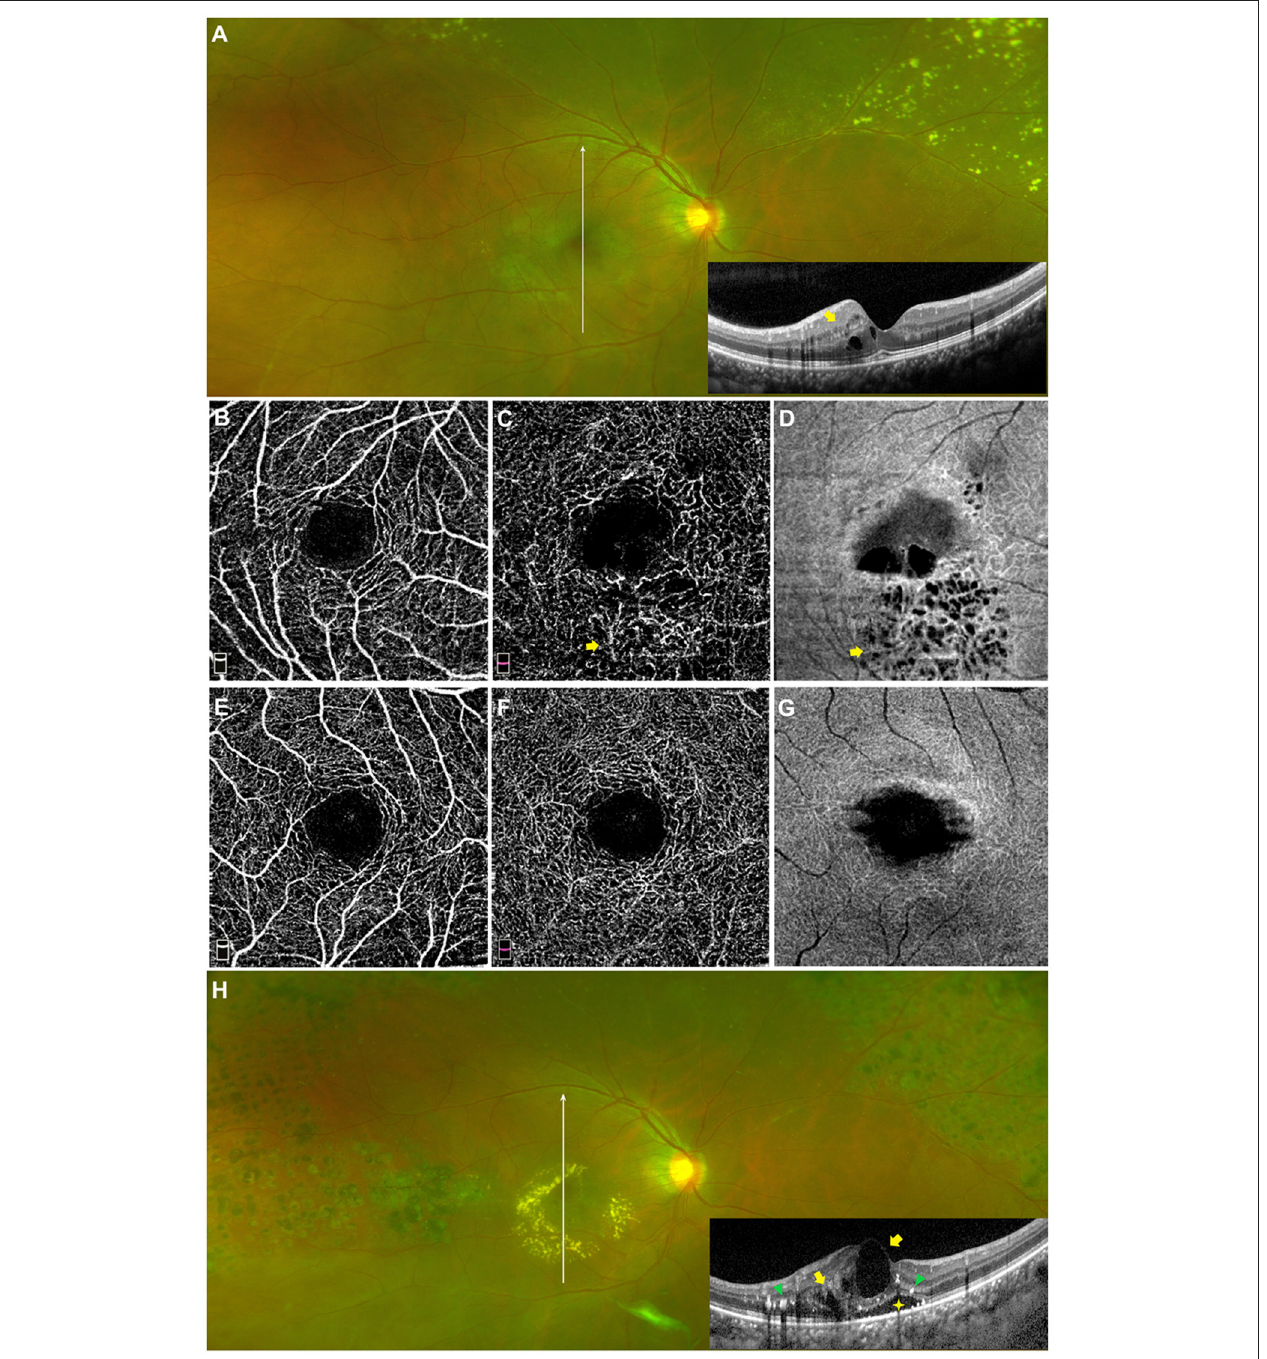
FIGURE 5 | Macular capillary loss at baseline in eye with refractory macular edema. A 17 years old juvenile with Coats’ disease presented as refractory macular edema. Macular edema on widefield fundus photography and on OCT imaging at baseline [ (A) yellow arrow]. Parafoveal VD losses in the SCP [ (B) VD: 38.5%] and DCP [ (C) VD: 41.2%] of the affected eye at the baseline visit were quantitatively detected via OCTA (3 × 3mm), by contrast, parafoveal VDs in the SCP (E) and DCP (F) of the contralateral eye were 54.1 and 61.3%, respectively. Telangiectasia in the DCP of the affected eye at baseline was also revealed, which was located in the parafoveal inferior region on OCTA enface imaging [ (C) yellow arrow], in correspondence to the hyporeflective cystoids on OCT enface imaging [ (D) yellow arrow]. OCT enface imaging targeting on the macula of the contralateral eye (G) . The macular lesion in the affected eye aggravated and presented as enlarged intraretinal cystoid spaces (yellow arrows) with hyperreflective exudates (green triangles) as well as subretinal exudates and fluid (yellow star) (H) .